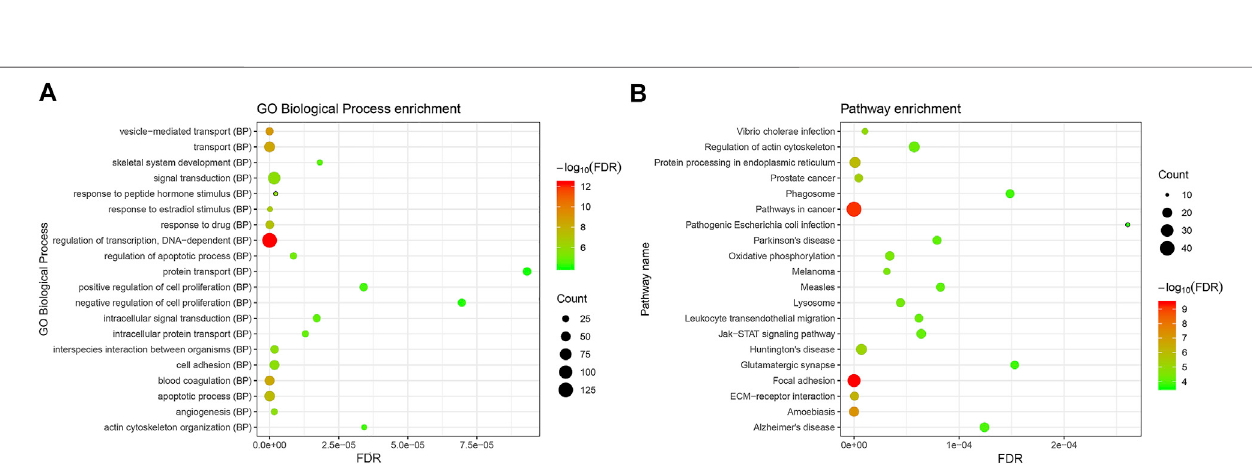
FIGURE 3 | The enriched biological functions and pathways of the DEMs in the DEMis-targeted DEMs network in IDD. (A) The enriched biological process of targeted DEMs; (B) the enriched KEGG pathway of targeted DEMs. DEMs: differentially expressed mRNAs; IDD: intervertebral disc degeneration; and KEGG: Kyoto Encyclopedia of Genes and